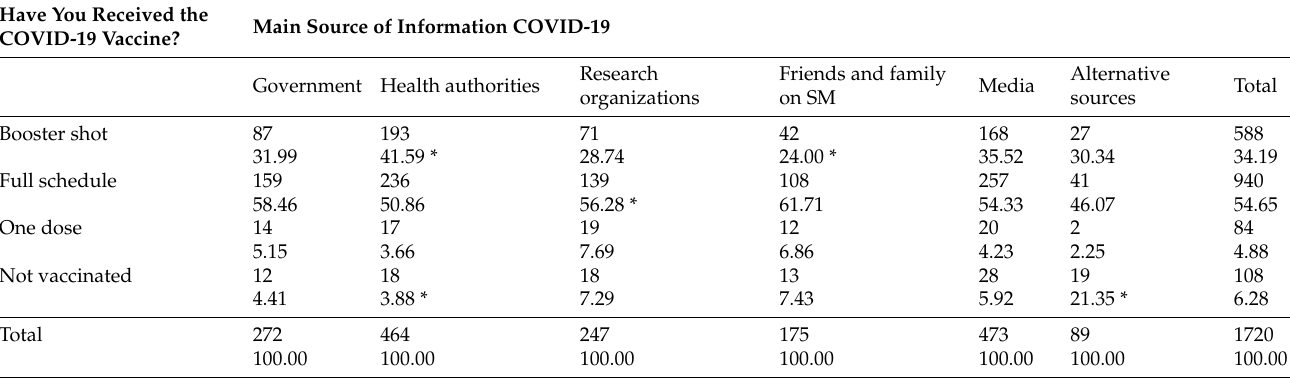
Table 4. The association between vaccination status and information sources.